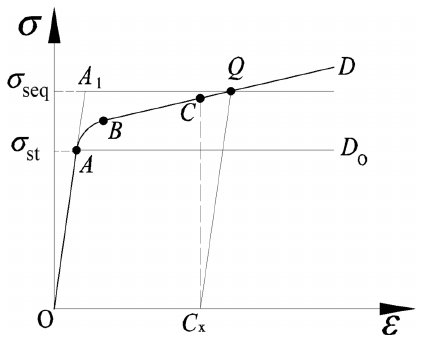
Figure 3. Schematic diagram for determining the equivalent yield strength.